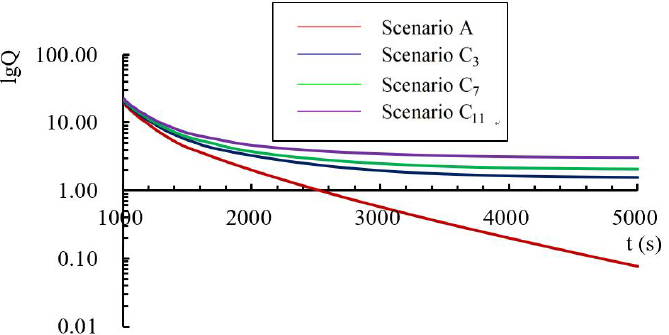
Figure 16. Recession curves of spring hydrographs with different injection rate at W4.